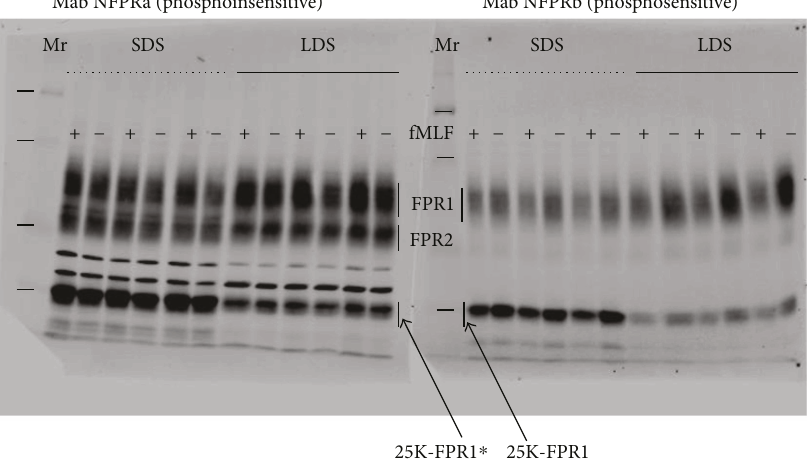
Figure 3: Degree of FPR1 proteolysis depends on conditions of cell solubilization. Six wells on each of two 96-well microtiter plates were loaded with 5 × 10 5 PMN in 50 μ L RPMI bu ff er and exposed to 1 μ M fMLF ( + ) or RMPI vehicle and equilibrated for 10 min at 37 ° C as described in Section 2. Subsequently, the supernatants were removed and replaced with 50 μ L of ice-cold DPBS. One plate was placed on ice and the other kept at room temperature for 2-3min followed by careful replacement of the added bu ff er with ice-cold TL bu ff er or room temperature TS bu ff er. The plates were agitated at 4 ° C and room temperature for 10min, respectively, and reduced and alkylated normally as described in Section 2. Two identical sets of 12 lanes were loaded with alternating lanes containing (13.3 × 10 4 ceq/lane) extracts of cells exposed to 1 μ M fMLF ( + ) or control bu ff er ( − ) in sets of six. Those that had been extracted at room temperature with TS bu ff er are denoted with a dotted line and SDS label above. Those extracted at 4 ° C with TL bu ff er are denoted with a solid line with LDS label above it. The blotted transfer was cut into two identical halves, incubated with NFPRa (left half) or NFPRb (right half), and developed as described above. The broad band representing FPR1 is identi fi ed with a vertical black bar and FPR1 label between the two blots. The position of FPR2 detected by NFPRa is also similarly shown. The 25K-FPR1( ∗ ) fragments are identi fi ed with diagonal arrows beginning at either 25K-FPR1 ∗ on the NFPRa blot and 25K-FPR1 on the NFPRb blot. The positions of the relative molecular weight markers, Mr, are shown to the left of each blot with horizontal dashes. From top to bottom their values are 125, 78, 41 ǂ , and 27 thousand. Each experiment was performed in triplicate or duplicate from two separate PMN donors. ( ǂ : omitted for clarity on the NFPRb